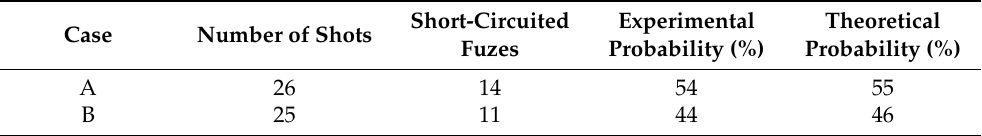
Table 2. Experimental results for the two considered slat armour prototype systems and a comparison with their theoretical